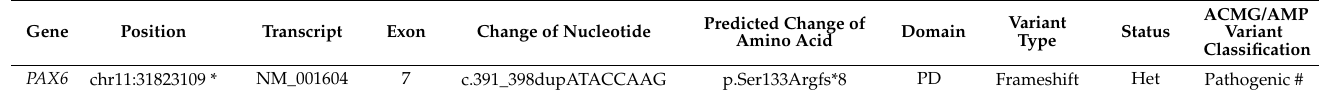
Table 2. Summary of the PAX6 gene and its